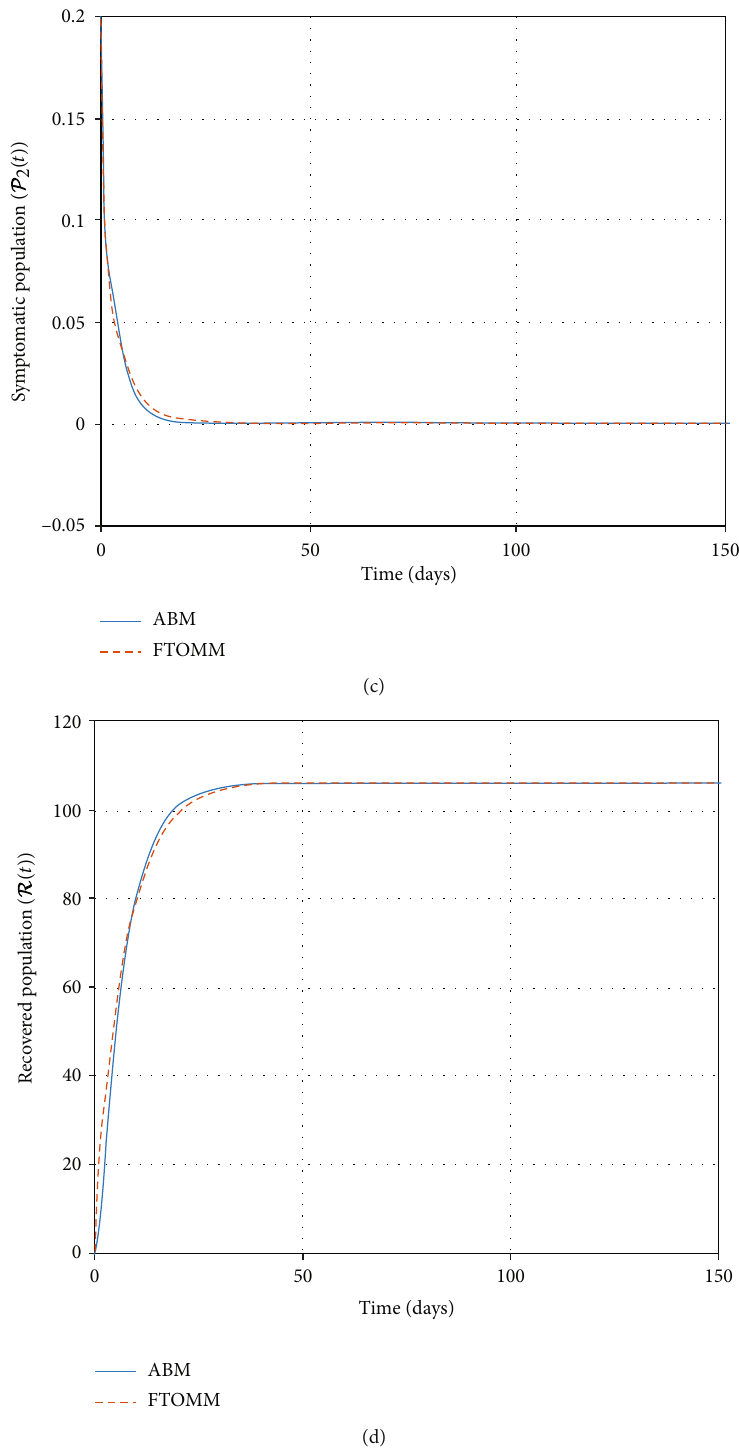
Figure 14: Comparisons between the ABM and FTOMM for the parametric values of S